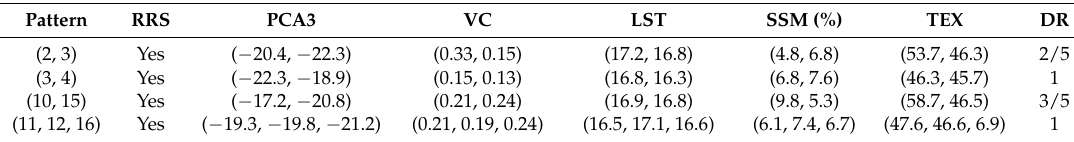
Table 3. Determination of table instances.